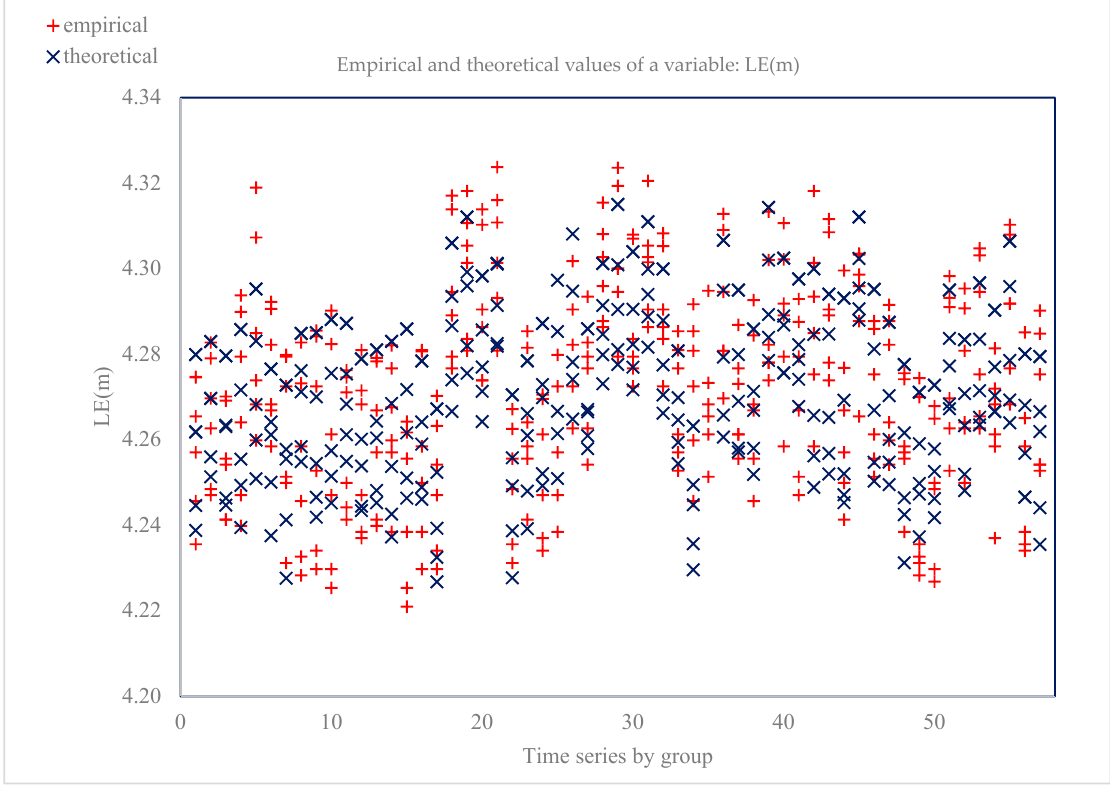
Figure 1. Empirical and aligned variable values (dependent variable LE (m) = 0). empirical Empirical and theoretical values of a variable: LE(f) theoretical